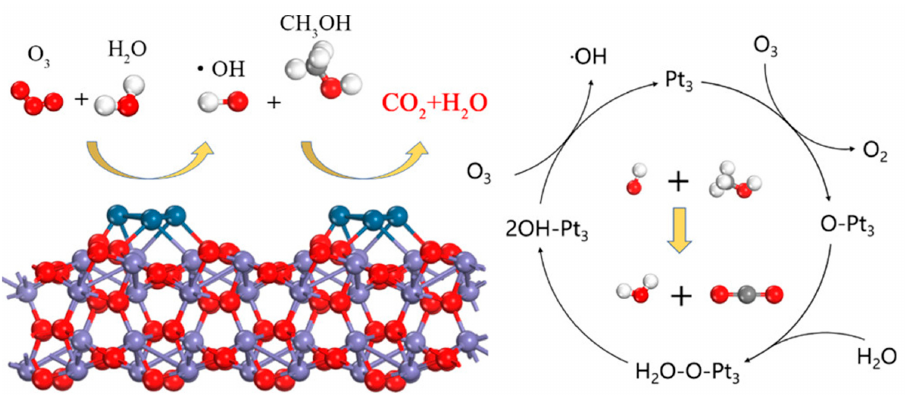
Figure 1. Reaction mechanism of Pt/FeO x catalyst for methanol catalytic ozonation at ambient temperature. Reprinted with permission: Copyright American Chemical Society 2020 [53].